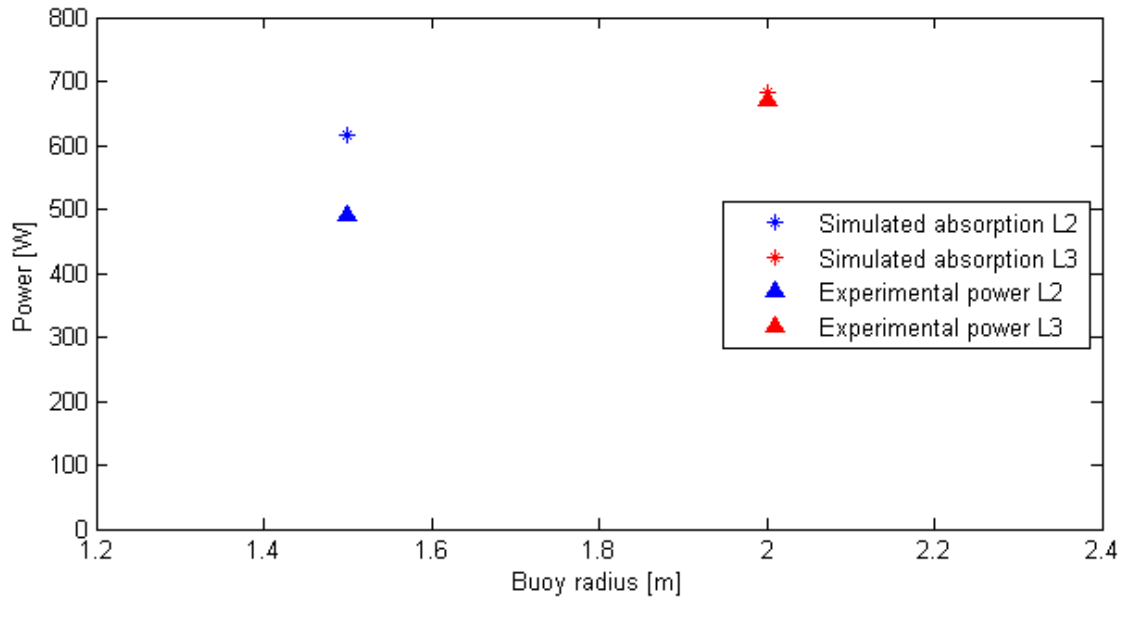
Figure 8. The simulated and experimental power absorption of the WECs L2 and